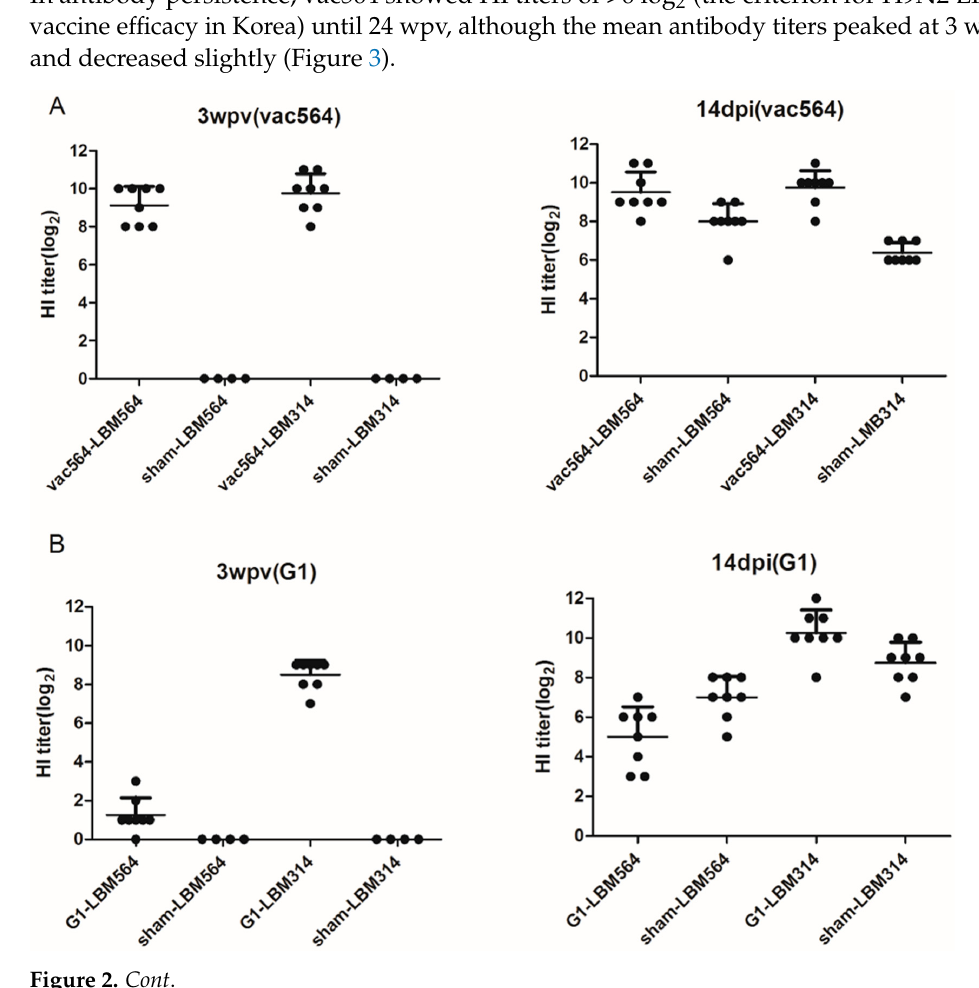
Figure 2. Antibody responses induced by vac564 and G1 lineage vaccines at 3 weeks post- vaccination (wpv) and at 14 days post-infection (dpi). Hemagglutination inhibition (HI) and serum neutralization (SN) assays were performed. ( A ): vac564 vaccination-challenged group. Black circles indicate the HI titers. ( B ): G1 vaccination-challenged group. Black circles indicate the HI titers. ( C ): G1 vaccination-challenged group. White circles indicate the SN titers. For serum analyses, G1 used the challenge strain as the antigen.